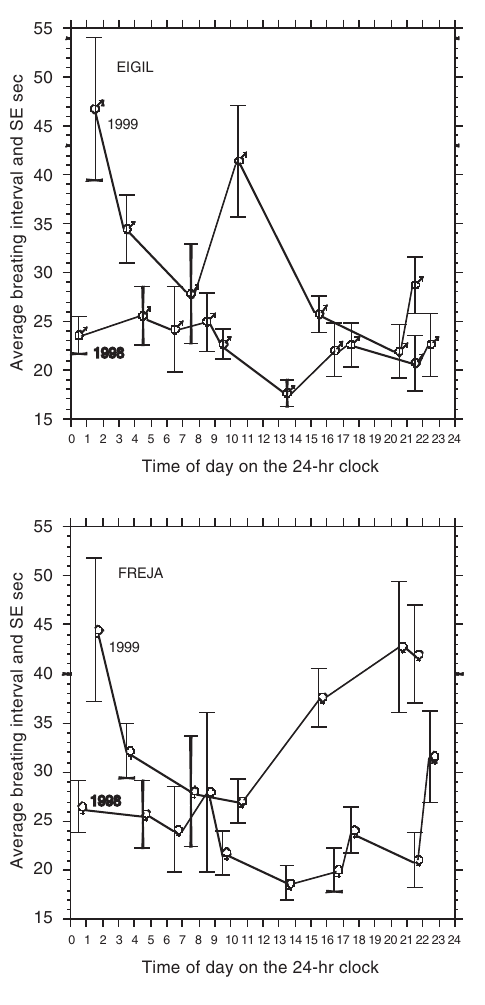
Fig. 10. Average breathing interval for Eigil and Freja, 20-21October 1998 and 9-10 February